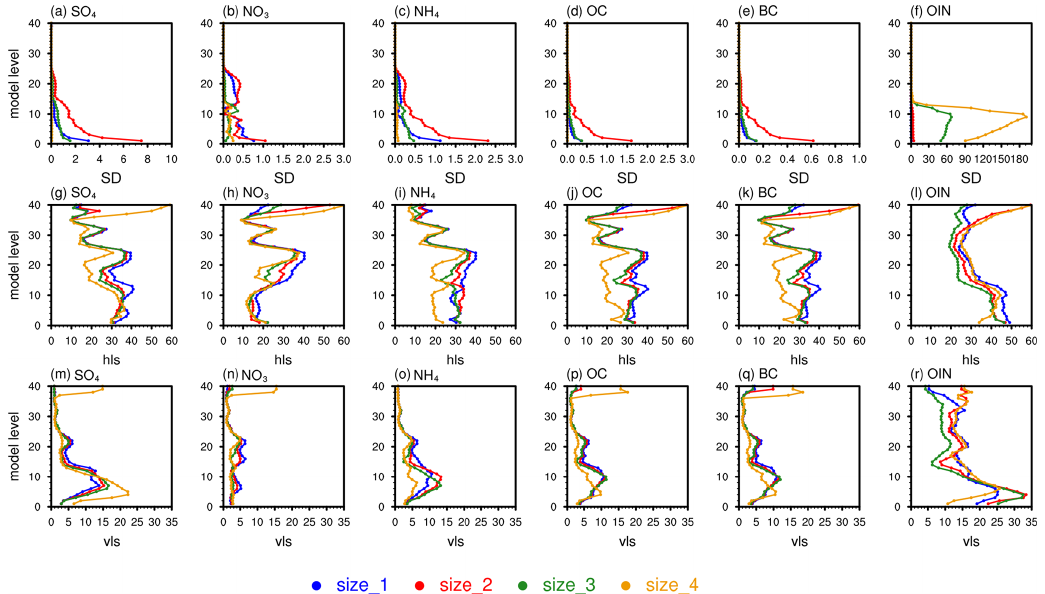
Figure 3. Background error standard deviations at Kashi grid (std, a – f , µgkg − 1 ), horizontal correlation length scales (hls, g – l , km), and vertical correlation length scales (vls, m – r ,km) at 00:00UTC in April 2019 for the sectional sulfate (SO 4 ), nitrate (NO3), ammonium (NH4), organic aerosol (OC), black carbon (BC), and other inorganic aerosols (OIN, including dust) in model domain 2. The horizontal and vertical correlation length were computed based on the latitude bins with a half degree